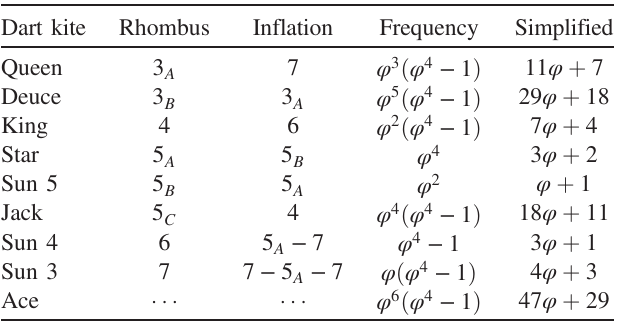
TABLE I. The vertices in the dart-kite P 2 tiling (Fig. 3); their equivalents in the rhombic P 3 tiling; their inflations in P 3 ; their relative frequencies; simplified forms of the frequencies, making use of the defining equation of the golden ratio φ 2 ¼ φ þ 1 .